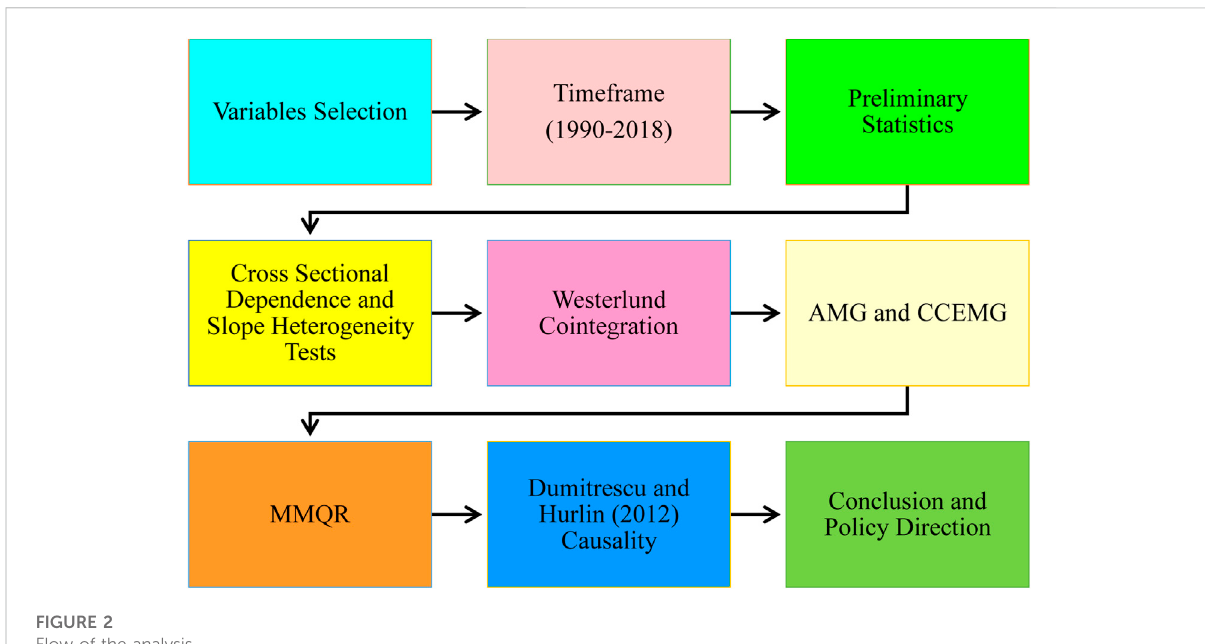
FIGURE 2 Flow of the